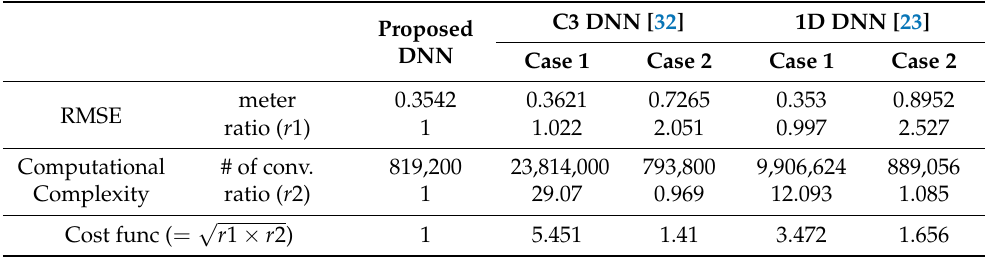
Table 10. Comparison of actual measurement performance between the proposed DNN structure and the DNN structure of the existing